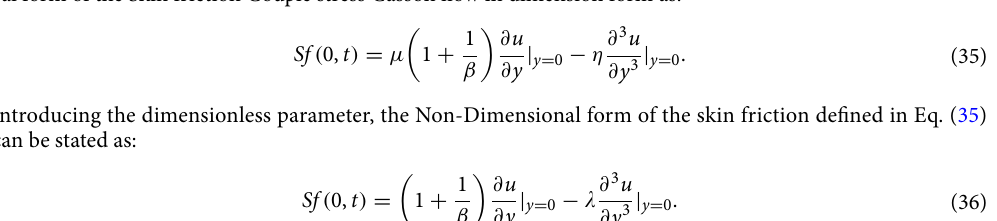
Skin friction, Nusselt and Sherwood number